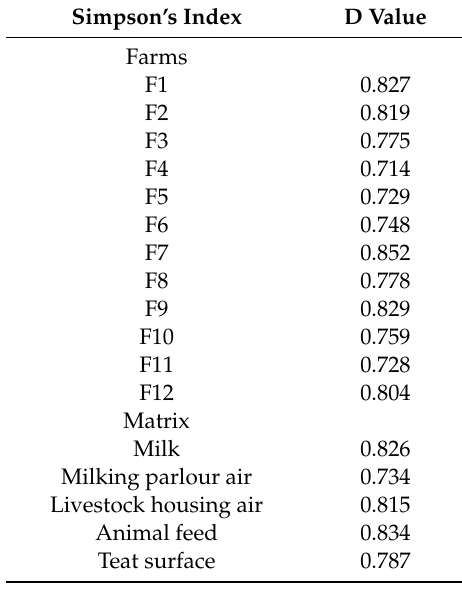
Table 2. Simpson index of biodiversity of species on each dairy farm and in each of the matrices: the value ranges from 0 to 1, where 1 represents infinite diversity and 0 represents no diversity.